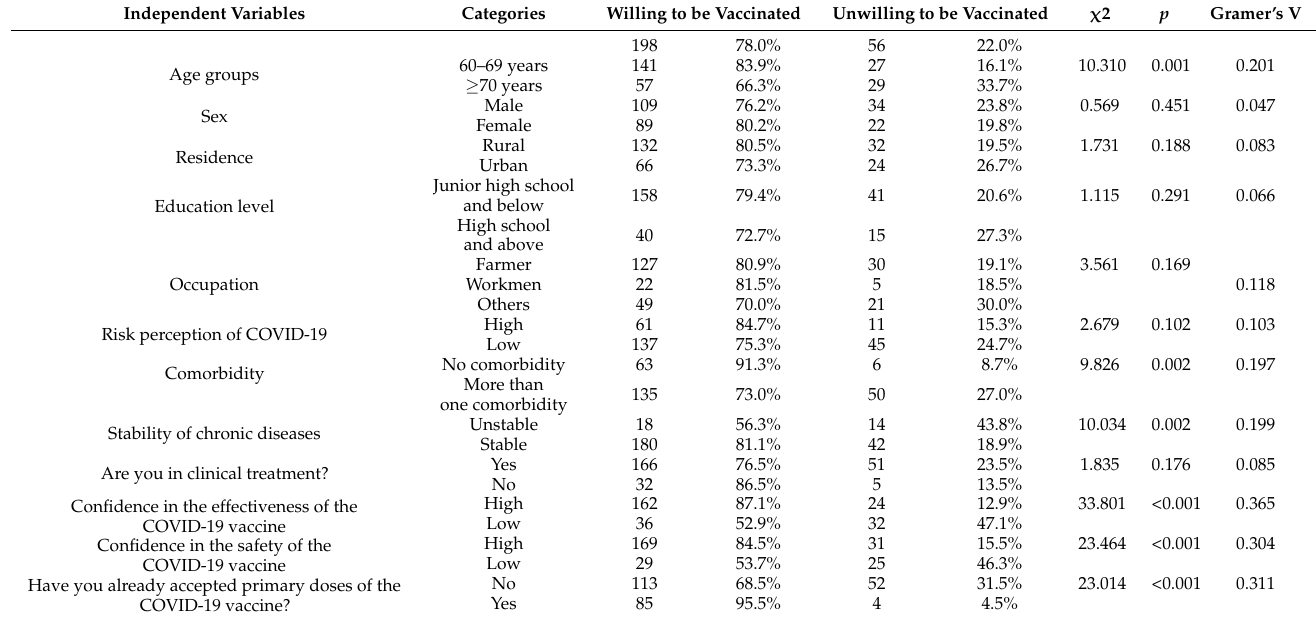
Table 2. Cardinal analysis of factors influencing the acceptability of COVID-19 vaccine booster vaccination among older adults with chronic diseases, n =